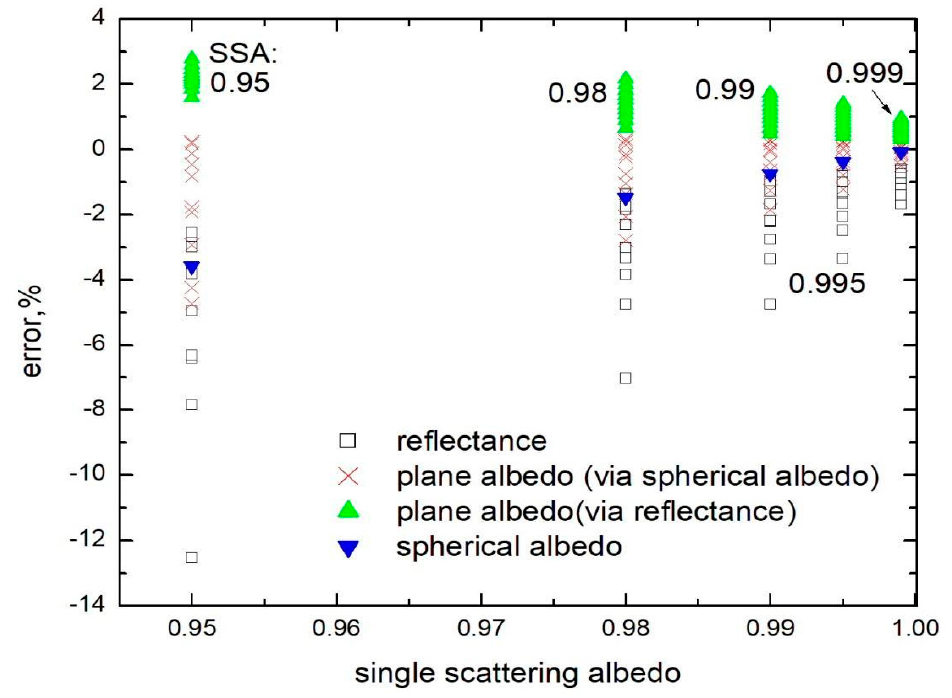
Figure 5. The relative errors of approximations. Remote Sens. 2019 , 11 , x FOR PEER REVIEW